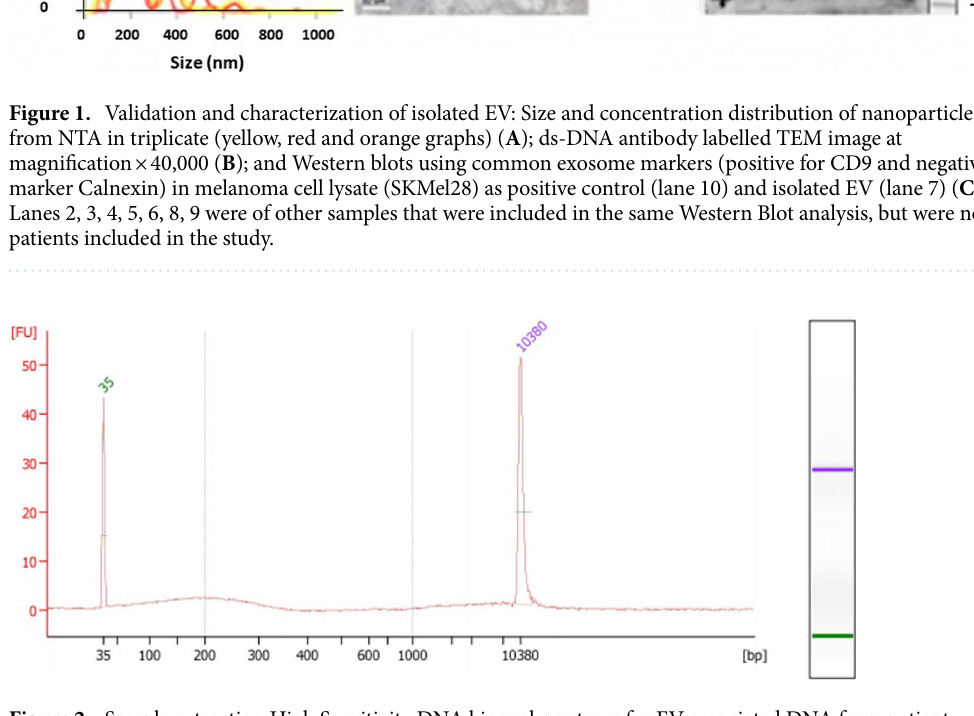
covering 0.76 Gbp (range 0.29–1.5 Gbp) in length. The mean number of CNA and length of abnormal DNA that overlapped between both the FFPE samples and EV samples for the same patient for the whole cohort was